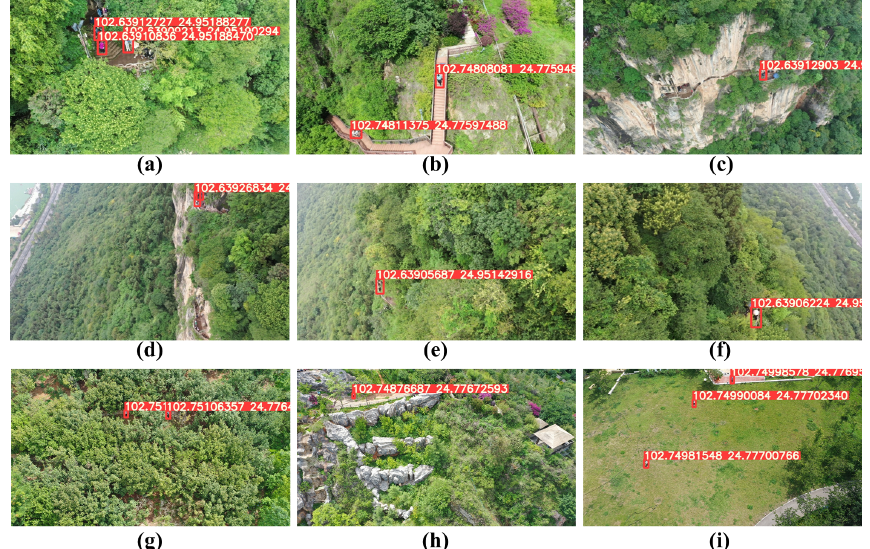
Figure 7. The positioning results shown in each image are consistent with the Positioning Lng, Lat column in Table 3. The scene in ( a – f ) is in the Xishan Forest Park, which has steep terrain and contains complex environments such as mountain roads and cliffs. The scene in ( g – i ) is in Gudian Wetland Park, with selected scenes of woods, meadows, etc. Table 3. Target positioning